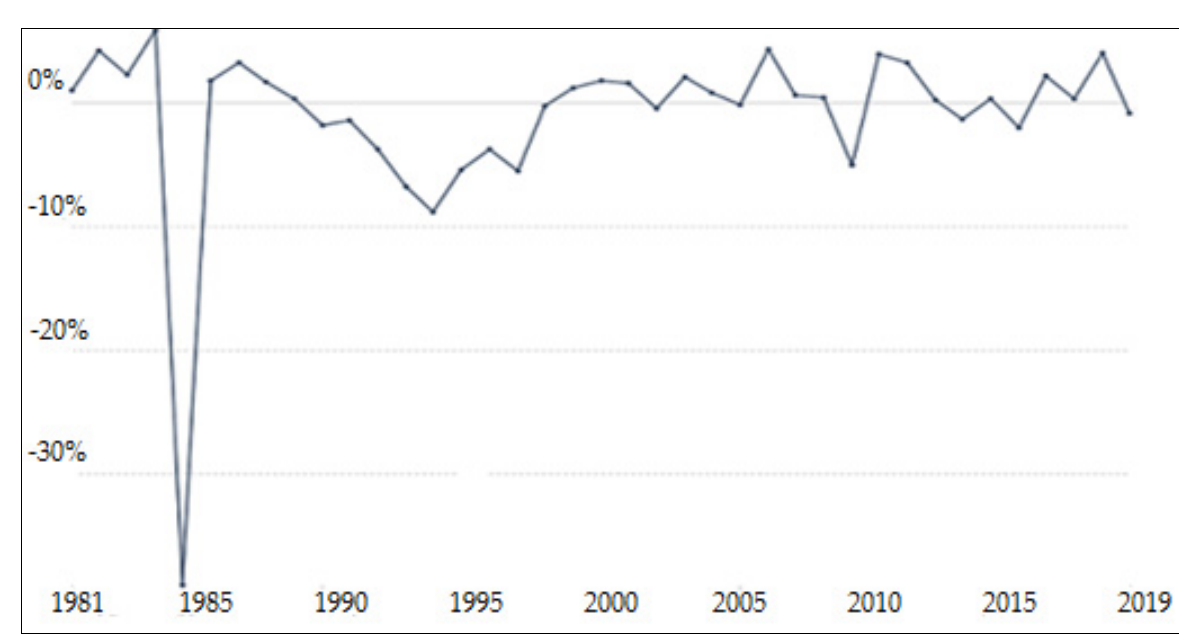
Figure 1. Total energy production. Source: [33].